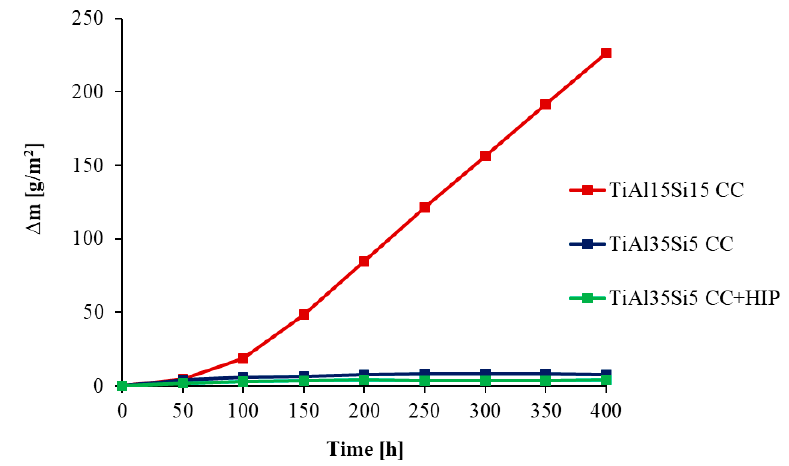
Figure 6. Dependence of the weight of delaminated oxides of Ti-Al-Si alloys on the time of cyclic oxidations (800 °C; 400 h).